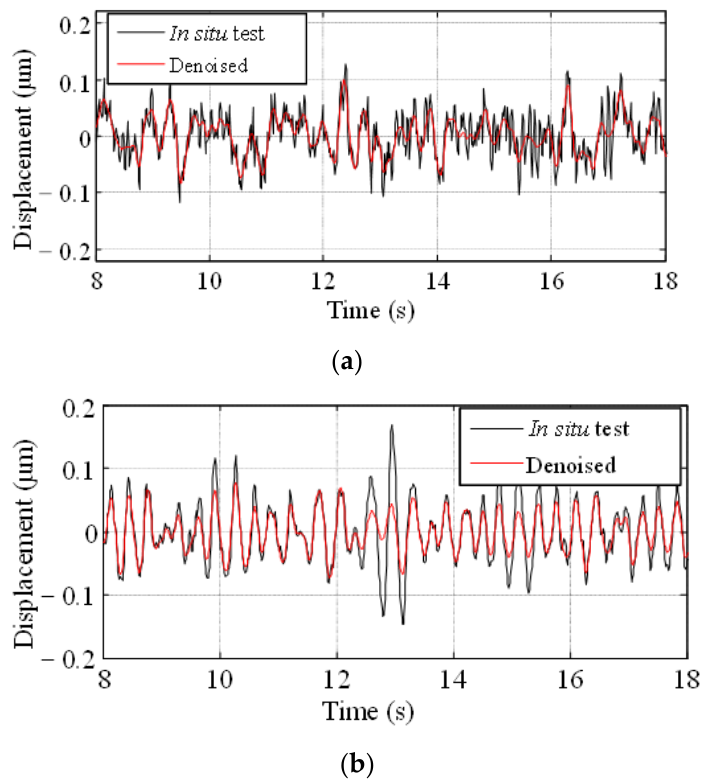
Figure 13. Time history curves of original signal and denoised signal at orifice( a ) and T9 ( b ).